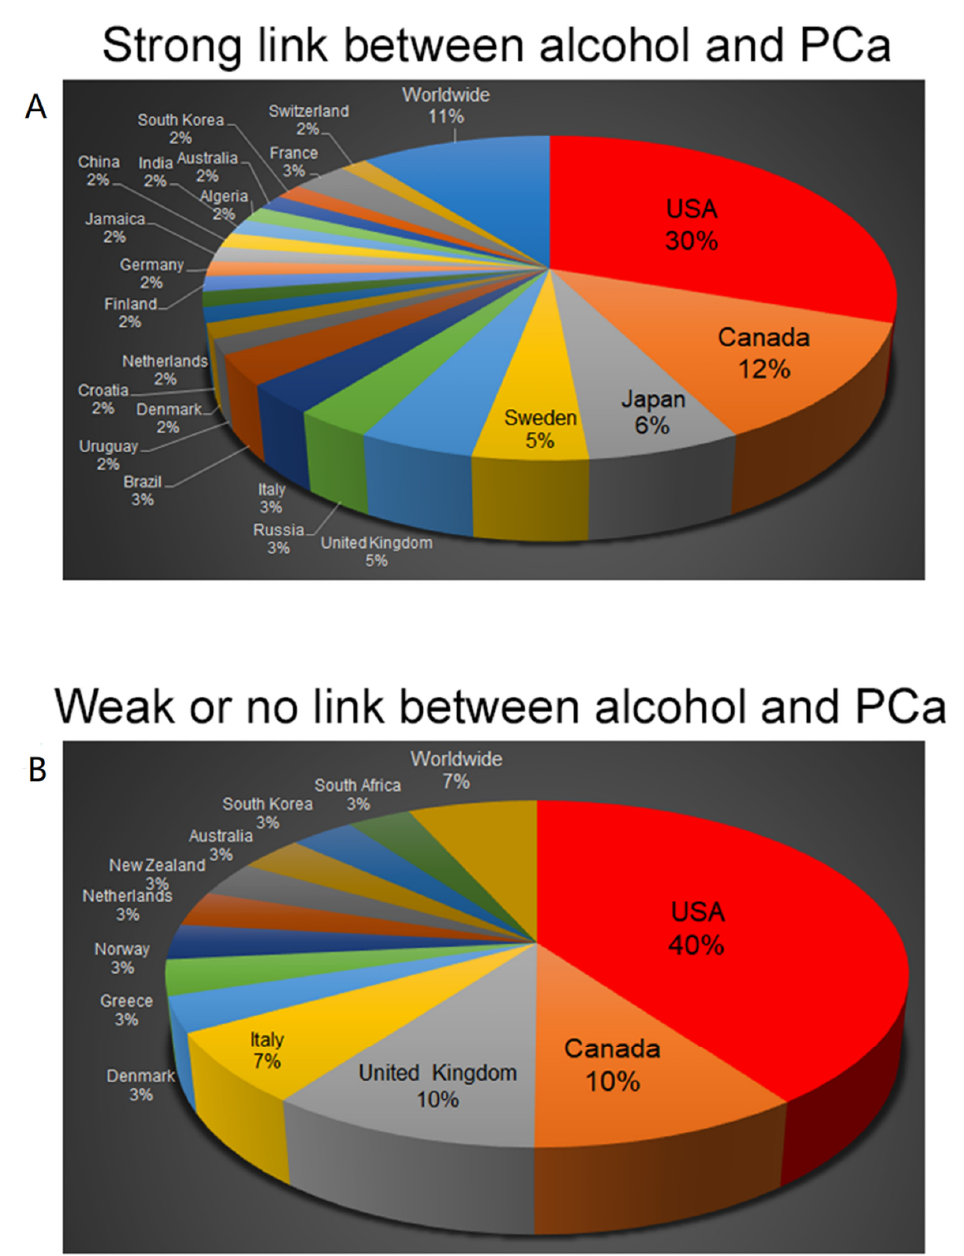
Figure 2. Geographical distribution of the case-control and cohort studies of alcohol association with risk of PCa. Note that epidemiological observations founding strong association between alcohol and PCa risk ( A ) represent a larger number of countries (23) than those denying such a link (( B ), 13 countries).